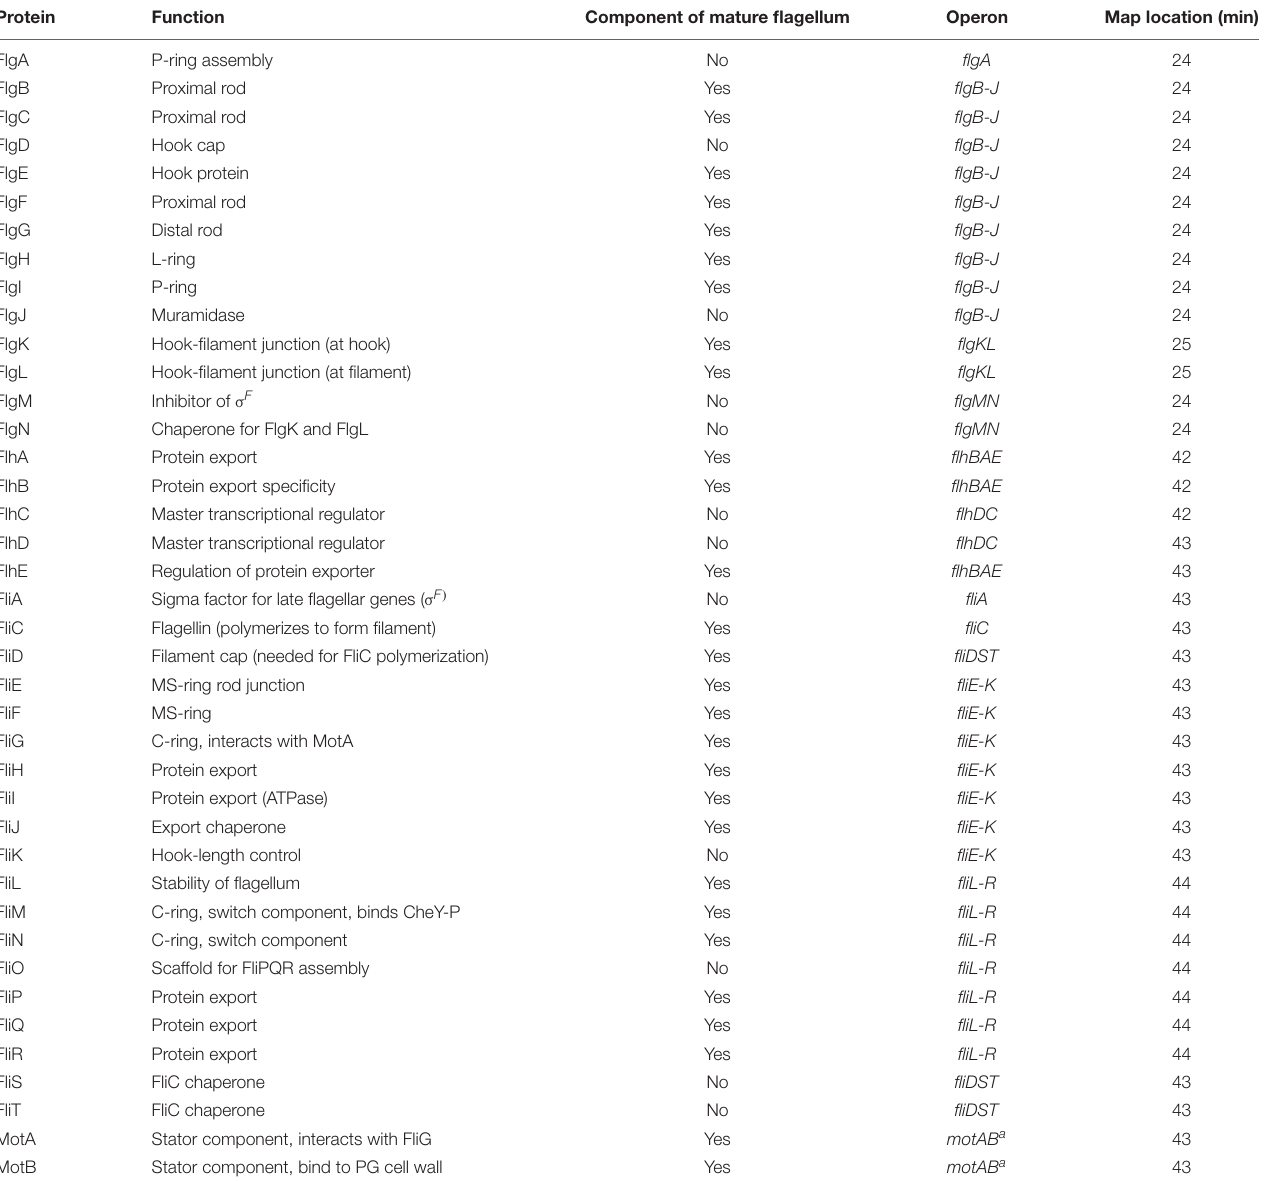
TABLE 1 | Proteins involved in the regulation, assembly, and structure of the E. coli flagellum. Protein Function